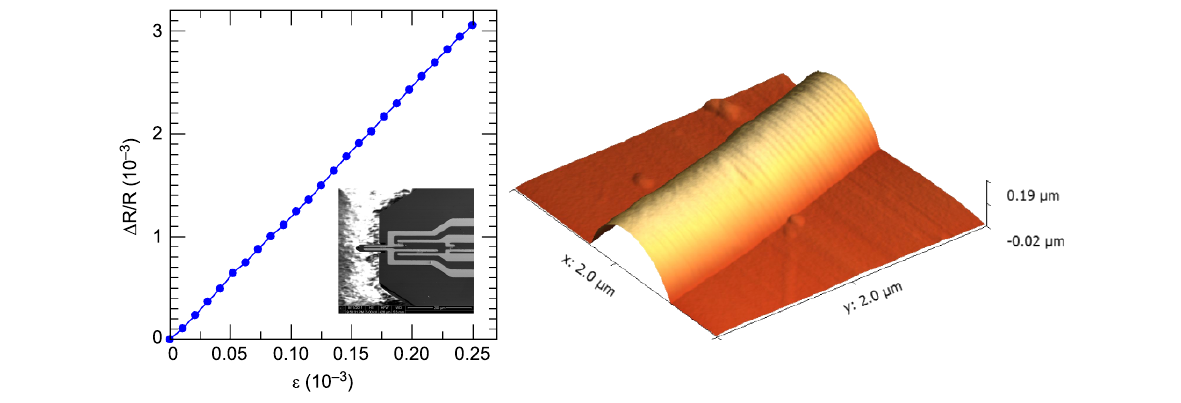
Figure 16: Left: Strain-resistance effect of a Pt–C nanogranular sensor element measured on a test cantilever (see inset). The sensor elements were prepared by FEBID employing the precursor Me 3 Pt(IV)CpMe at 5 keV beam energy, 1.6 nA beam current, 20 nm pitch and 1 μ s dwell time. Within a full Wheatstone bridge each individual sensor element had a resistance of 51 k Ω . The Si (100) test cantilever had dimensions of 70 × 35 × 3 μ m 3 . Right: Exemplary AFM image of collagen fibril taken in noncontact mode at a resonance frequency of 420 kHz. The images were taken with an adapted MultiMode atomic force microscope with Nanoscope 3a controller at 0.2 Hz line